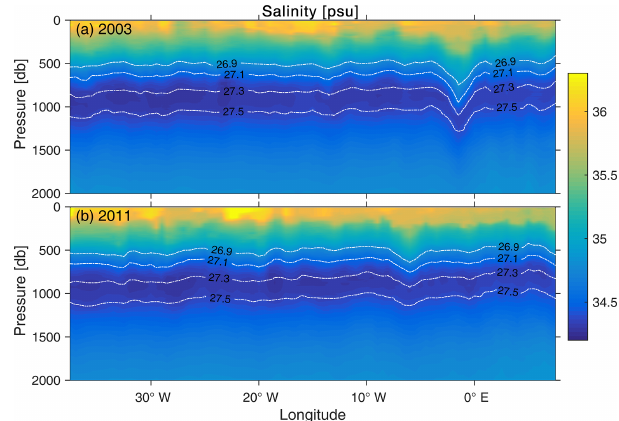
Figure 1. WOCE salinity sections along 30 ◦ S in the South At- lantic Ocean (positions shown in Fig. 2) observed in (a) 2003 and (b) 2011. Overlaid white solid–dotted lines are γ n surfaces ranging from 26.9 to 27.5kgm − 3 , with a 0.2kgm − 3